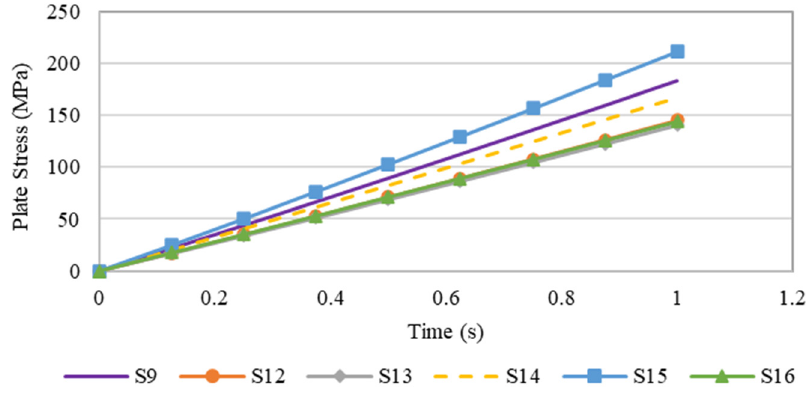
Figure 18. Graph plot of the maximum stress of steel plate specimens with different plate opening numbers over time.